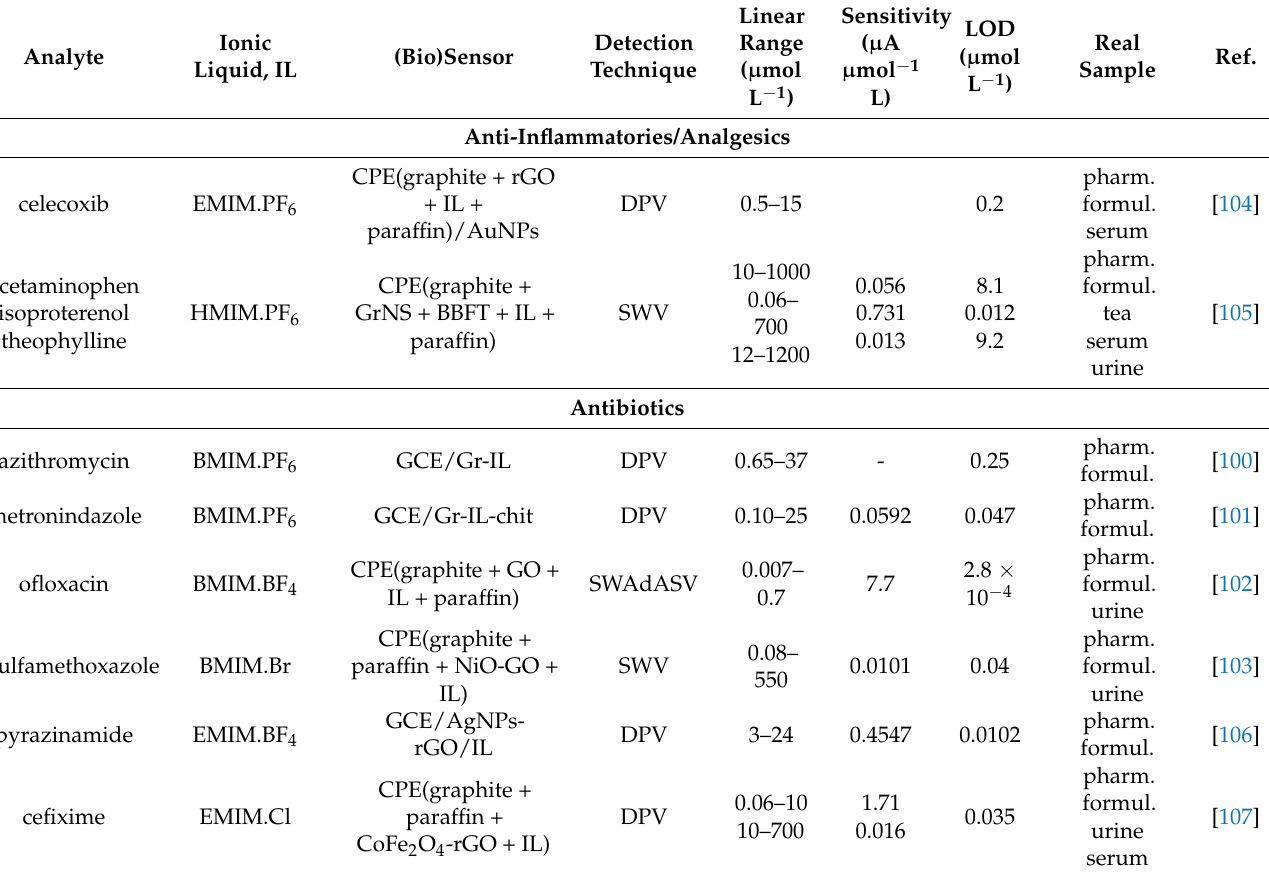
Table 4. Other graphene-IL-based electrochemical sensors for pharmaceutical